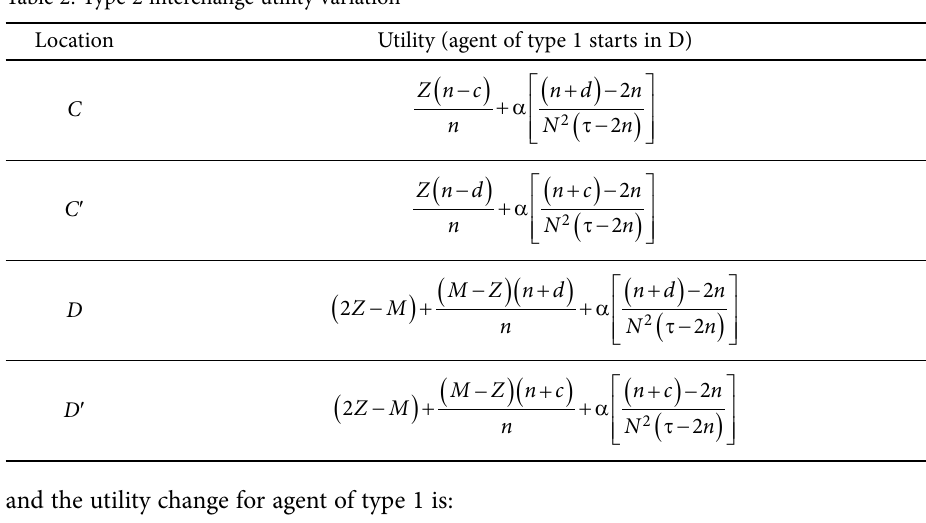
Table 2. Type 2 interchange utility